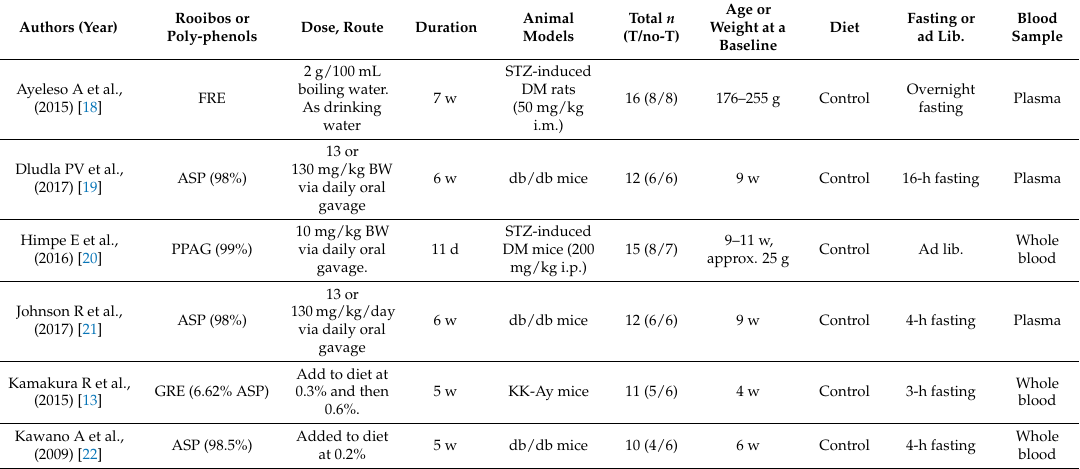
Table 1. Characteristics of included studies in the